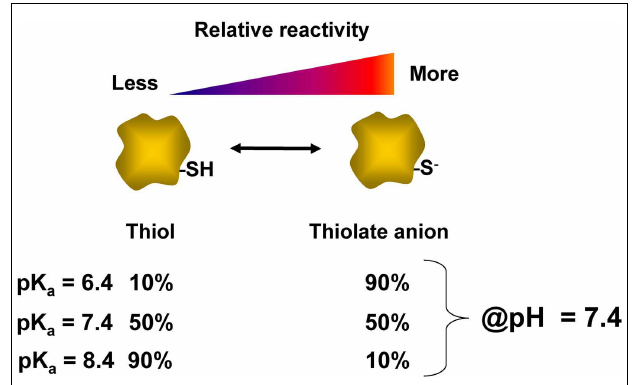
FIGURE 2 | Relationship of thiol pK a and reactivity. The acid dissociation constant (pK a ) of a thiol group determines the ratio of thiol:thiolate at a given pH.This value varies for each cysteinyl thiol and is influenced by the local protein environment. At a physiological pH of 7.4, the relative percentages of protonated thiol and deprotonated thiolate anion are listed for cysteine residues which have different pK a s of 6.4, 7.4, or 8.4.The thiol with a pK a of 6.4 is expected to be nearly 90% in the thiolate form at pH 7.4, and is therefore more reactive than thiols with higher pK a